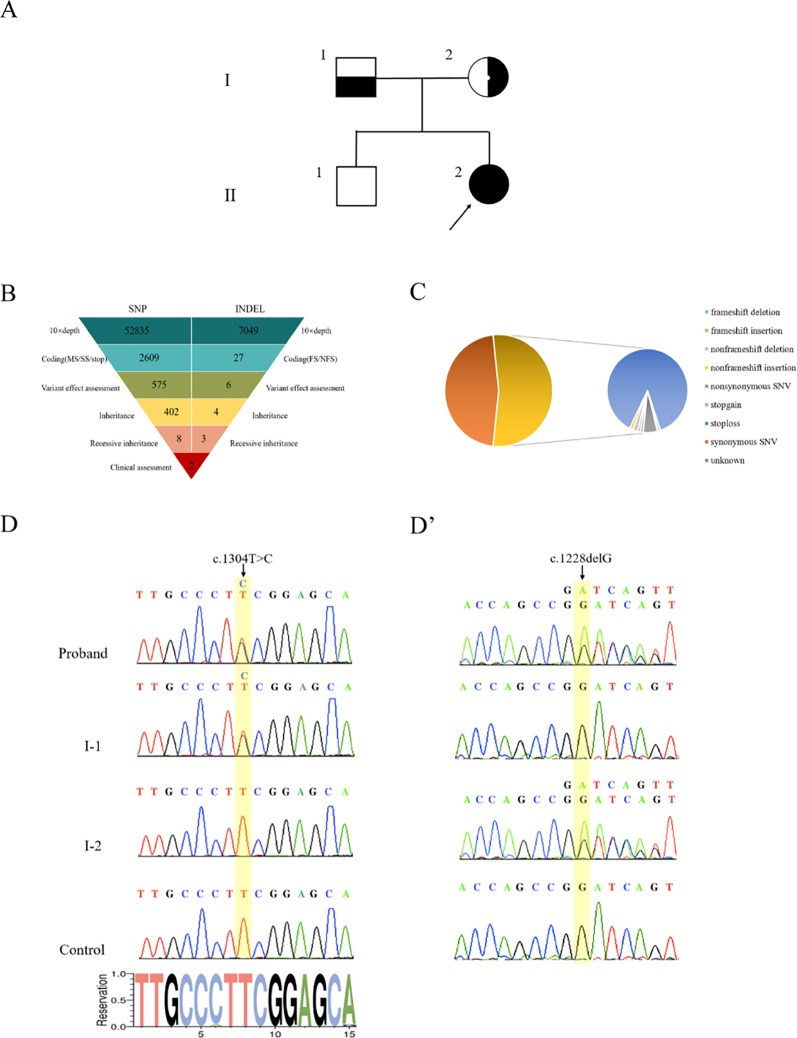
Genetic diagnosis. (A) The pedigree with 17α-hydroxylase/17,20-lyase deficiency. The arrowhead denotes the proband. (B) Schematic representation of the exome-data-filtering approach under the assumption of recessive inheritance in the family. The following abbreviations are used: MS, missense variant; SS, splice-site variant; stop, stop-codon variant; FS, frameshift indel; and NFS, non-frameshift indel. (C) Percentage of variants in exome regions. (D) Sanger sequencing chromatograms showing that the proband and her father (I-1) harbor a heterozygous c.1304T > C variant of the CYP17A1 gene. (D’) Sanger sequencing chromatograms showing that the proband and her mother (I-2) harbor a heterozygous c.1228delG deletion of the CYP17A1 gene.